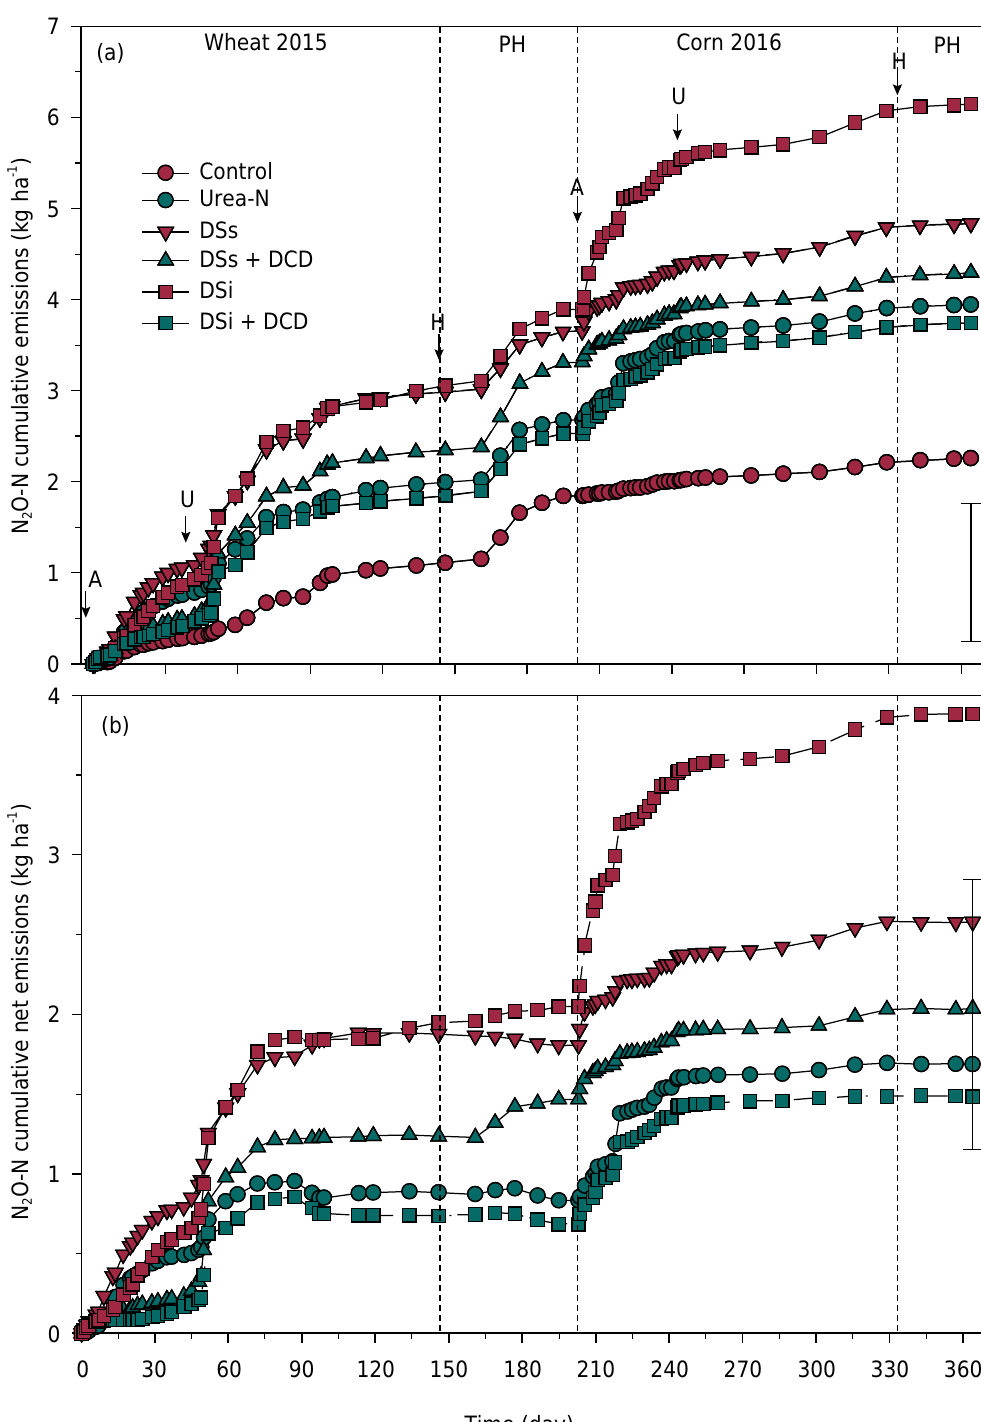
Figure 2. Cumulative emissions (a) and cumulative net emissions (b) of N 2 O evaluated during the wheat and corn growing seasons and post-harvest (PH) periods. Urea-N = surface-broadcast urea-N (traditional N fertilization); DSs = surface-broadcast DS; DSi = Shallow-injected DS; DCD = dicyandiamide. Arrows indicate treatments application at sowing (A), urea application at side-dressing (U), and harvest (H). The vertical bars indicate the minimum significant difference between the treatments by LSD test at 5